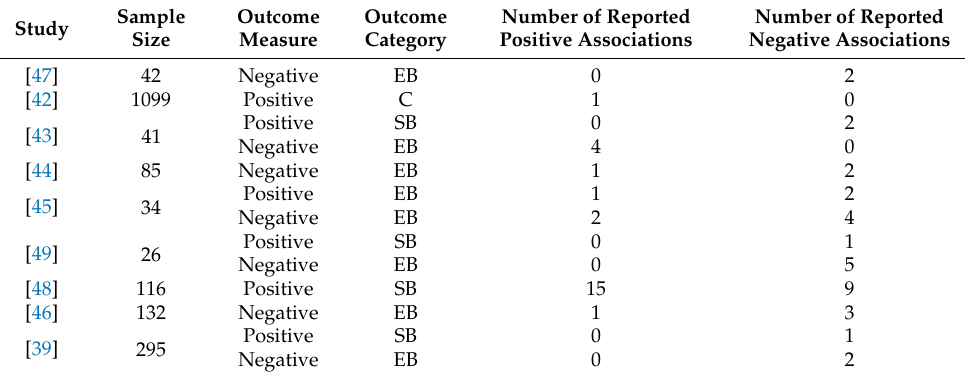
Table 7. Rough-and-tumble play—outcome measure descriptions and results